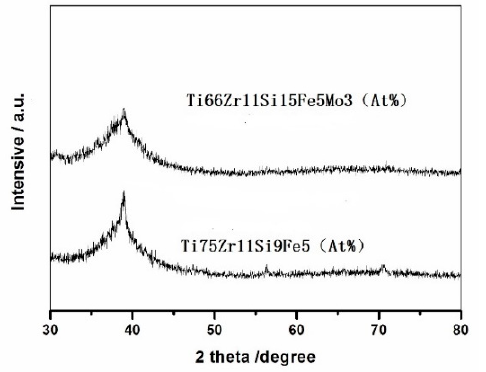
Figure 1. X-ray diffraction patterns of the as-quenched Ti66Zr11Si15Fe5Mo3 (At %) and Ti75Zr11Si9Fe5 (At %).